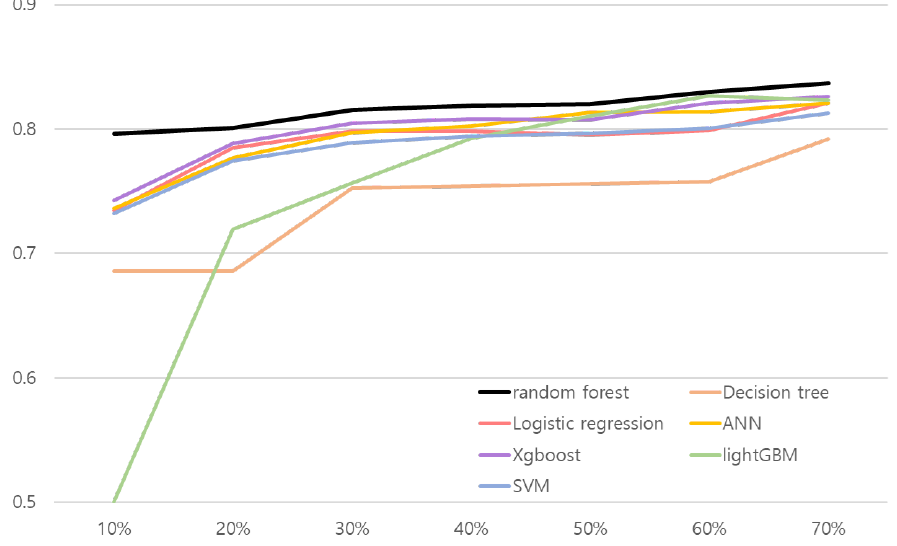
Figure 3. Line plot of liver cancer risk association model’s performance according to the number of train dataset. x and y axes represent the proportion of training data and AUC,